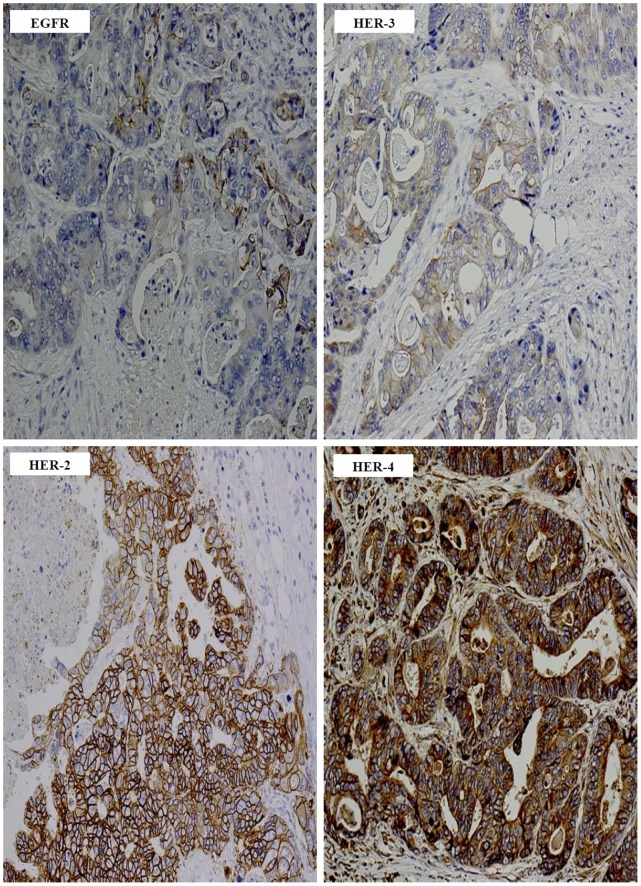
The co-expression of all HER family members in a patient with Dukes’ C colon cancer.Co-expression of EGFR, HER-2, HER-3, and HER-4 in a formalin fixed paraffin embedded tumour sections stained immunohistochemically as described under methods and patients section. Magnification: ×200.